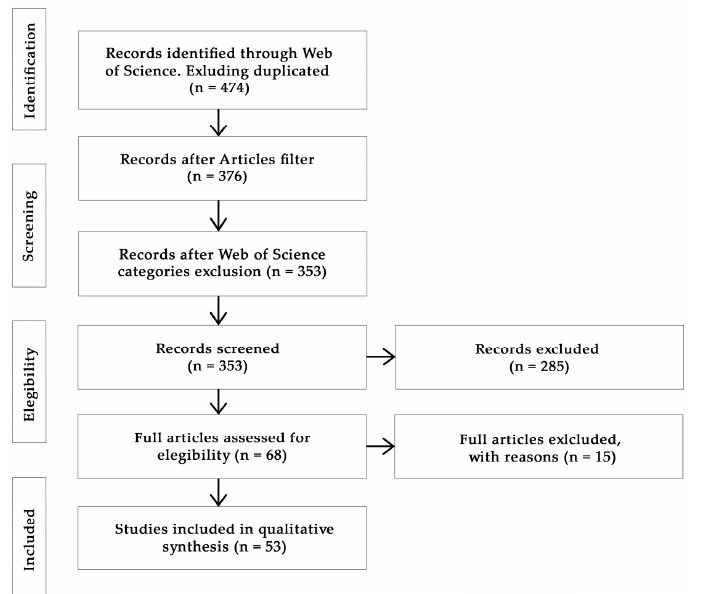
Figure 3. PRISMA flowchart summarizing the sequence of information gathering and selection for the systematic review.